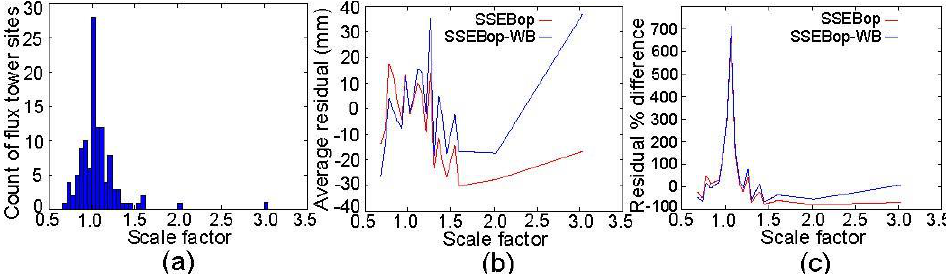
Figure 11. Comparison of SSEBop and SSEBop-WB relative to scale factor values at AmeriFlux sites. ( a ) Histogram of the distribution of scale factor values at flux tower sites; ( b ) Average magnitude of residuals for the tower measurements, relative to scale factor values; ( c ) Average percent difference between SSEBop or SSEBop-WB values and tower ET measurements, relative to scale factor values.